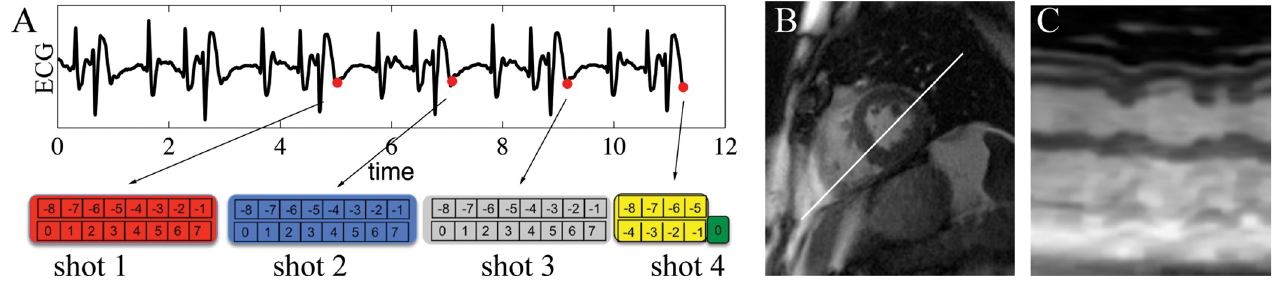
Fig 4. Utility of the proposed approach when imaging a patient with arrhythmia. A) The cross-correlation based approach robustly identifies similar periods in the cardiac cycle in the setting of arrhythmia. B) A high-quality short axis image can be generated with the closed-loop scheme. C) The temporal projection illustrates the effect of complex rhythm on wall motion. This suggests the close-loop approach could enable multi-shot imaging of patients with complex rhythms.